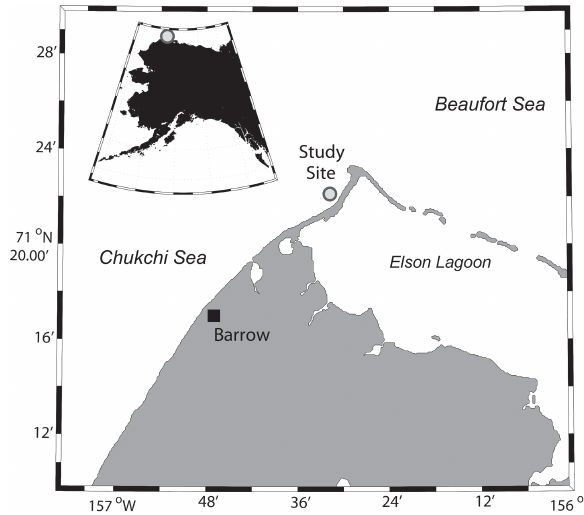
Figure 1. The study site (north of Barrow, Alaska,